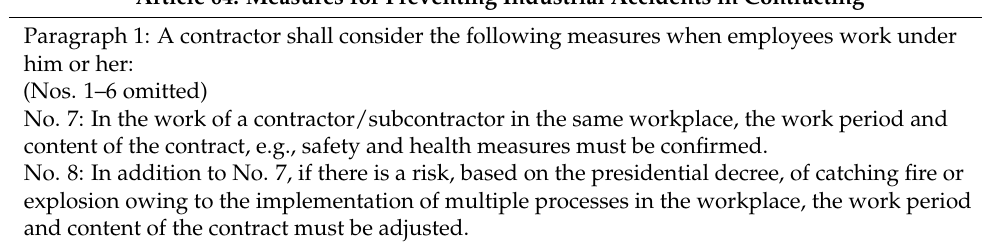
Table 1. Occupational Safety and Health Act Article 64, Paragraph 1, No. 7, No. 8 (in Korea). Article 64: Measures for Preventing Industrial Accidents in